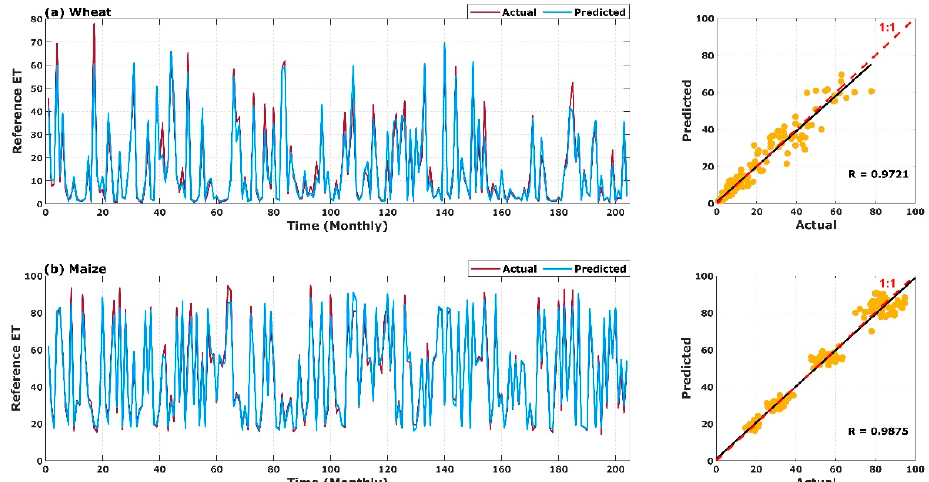
Figure 5. Demonstrating cross validation for correlation coefficient between actual and predicted crop reference evapotranspiration magnitudes for ( a ) wheat and ( b ) maize crop for the study region [Actual and predicted monthly scale values are shown through time series (left) and scatter plots (right). In the scatter plots, dashed red lines show the 45° line (1:1; line of perfect simulation), and the other line shows best-fit lines for the scatter plots].